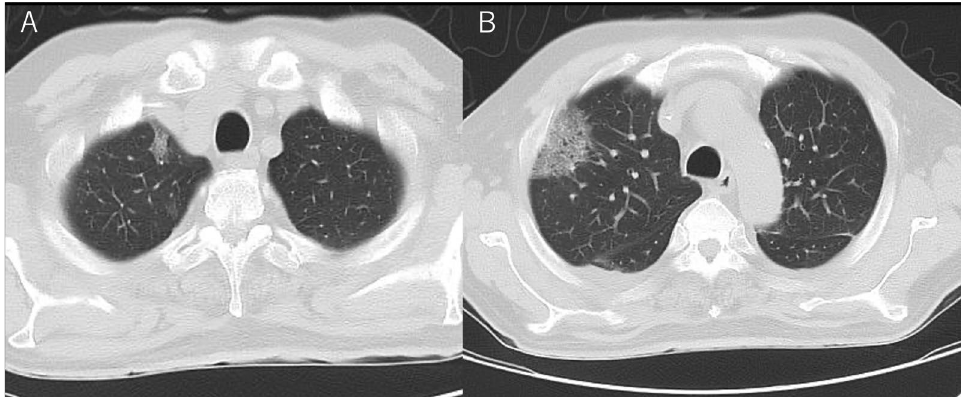
Fig. 4 Chest computed tomography scan obtained on the second day after admission. A The appearance of a new GGO in the right upper lobe. B The existing GGO appears enlarged and shows thickening of the interlobular and intralobular septal walls. GGO ground-glass opacity